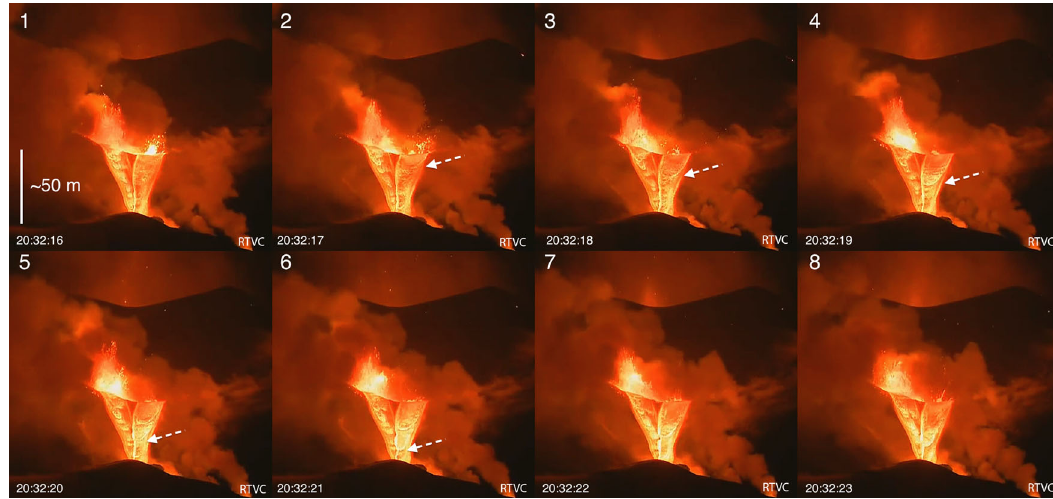
Fig. 2 Cascading lava streams at Cumbre Vieja, 18 November, 2021. Montage of image frames (1 – 8) collected from an open-source video feed (RTVC/TV- Canarias) of the eruption on 18 November 2021, at approximately 20:32h local time. These images depict twin “ lava cascades ” that erupted over a period of about 30min, and were sourced from two newly formed (~20:23 local time) and closely spaced, fountaining vents positioned atop a steep crater wall. The eruptive cone ’ s peak is visible in the background. The series of images progress chronologically from left to right in each row, providing a short (~7s) timeframe of this activity, so as to highlight features of the highly fl uid, freshly emergent lava. The white arrows indicate the formation and displacement of one of several blunt arcuate fl ow fronts that formed mid-channel and whose progression downslope caused an intensifying of the incandescent fringe that demarcates the fl ows ’ fronts and margins. These features — the blunt fronts — formed in pulses every 1 – 3s and maintained their form despite fl owing on previously wetted lava channels. The last two frames (7 and 8) depict the formation and progression of a new front. This behavior resembles that of water- fl ow phenomena including bores and swash waves in that a distinct discontinuity or hydraulic jump is maintained 51 – 53 . Such repetitive fl ow lobe activity has not been observed in other parts of the fl ow fi eld and is likely a consequence of the ultralow viscosity and fast downward fl ow of proximal lava. These video data were furthermore used to determine advance rates (to ~12ms − 1 ).